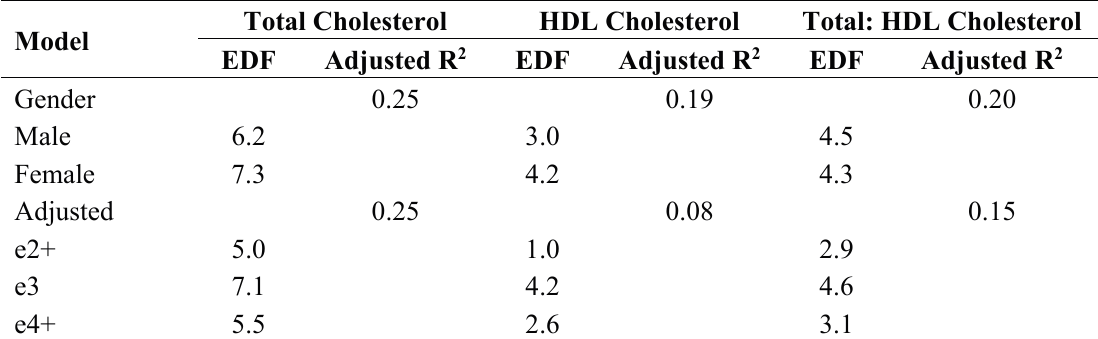
Table 5. EDF and adjusted R2 for trajectories of total, HDL, and total: HDL cholesterol ratio according to gender, and APOE allele status adjusting for age of